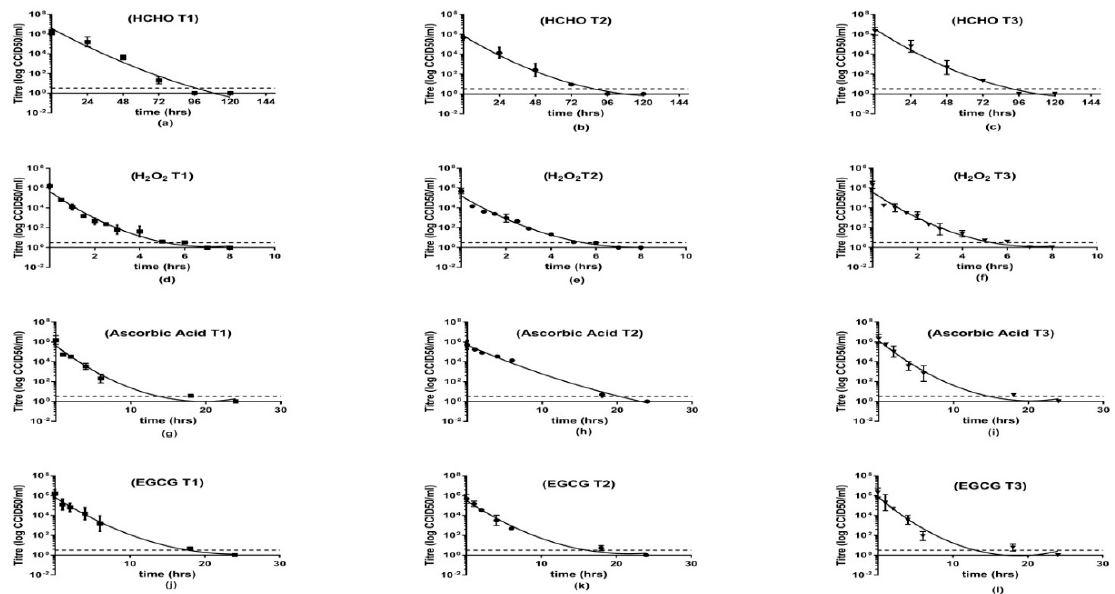
Figure 1. Inactivation kinetics of the three PV serotypes using different inactivating agents. Viral infectivity titers of the aliquots were determined by titration using Hep-2c cells in tissue culture microtiter plates. Each point is the average of two independent tests to measure the virus titer after a specific exposure time to the inactivating agent tested using tissue culture technique and expressed as log 10 CCID50/mL and the error bars show the standard deviation (SD). The curves are fitted using non linear regression of the data. PV1 is represented as squares, PV2 as circles and PV3 as triangles. The method limit of detection (0.5 log CCID50/mL) is indicated by horizontal dashed line also symbols below LOD indicate no detected CPE at those time points. ( a – c ) Effect of HCHO on the infectivity titers of PV 1, 2 and 3 respectively; ( d – f ) Effect of H 2 O 2 on the infectivity titers of PV 1, 2 and 3 respectively; ( g – i ) Effect of ascorbic acid on the infectivity titers of PV 1, 2 and 3 respectively and ( j – l ) Effect of EGCG on the infectivity titers of PV 1, 2 and 3 respectively.